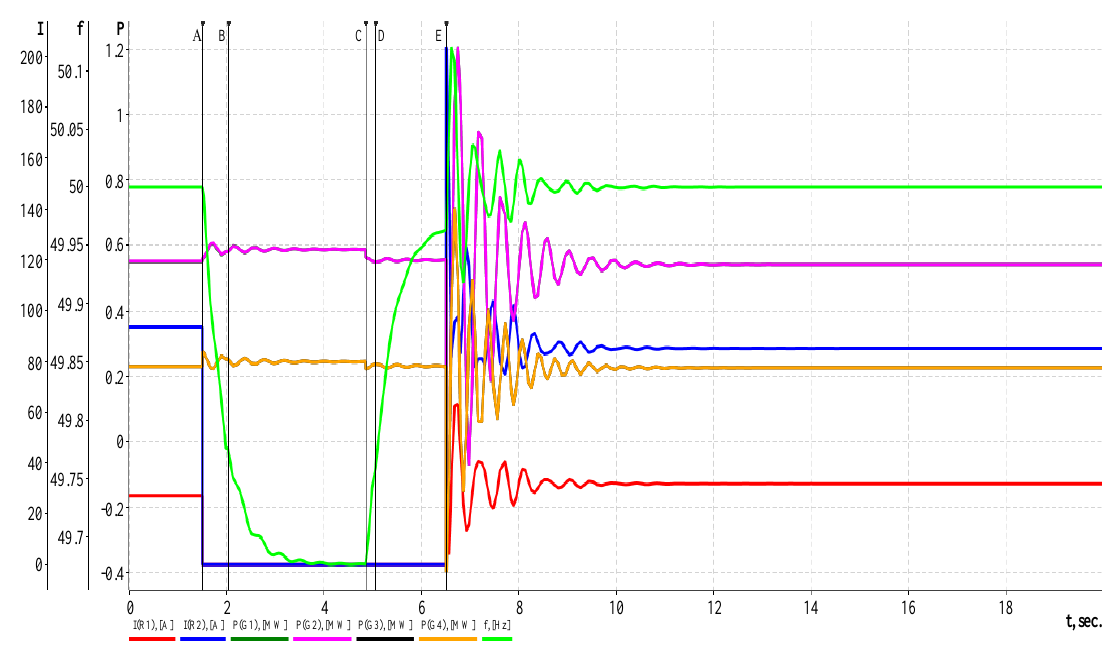
Figure 10. The microgrid transient response with 60% of the maximum load.